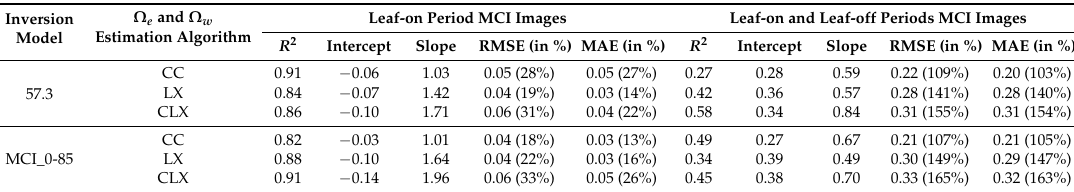
Table 10. Correlation statistics between the obtained α estimates (derived with consideration of Ω e and Ω w by using the leaf-on period MCI images) and the reference α of the five plots. Statistics are given at the 95% confidence level from the two-tailed Student’s t